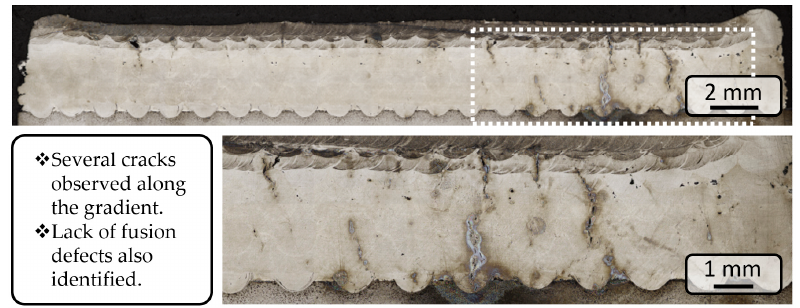
Figure 5. Macro metallographic inspection of the deposited FGM sample.